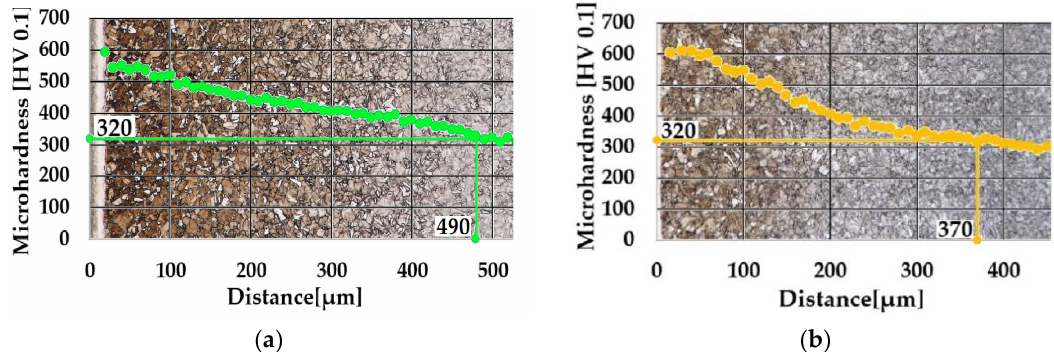
Figure 5. Profiles of microhardness. ( a ) Six hours of gaseous ferritic nitrocarburizing and ( b ) 6 h of plasma ferritic nitrocarburizing. Magnification of microstructure, 500×.